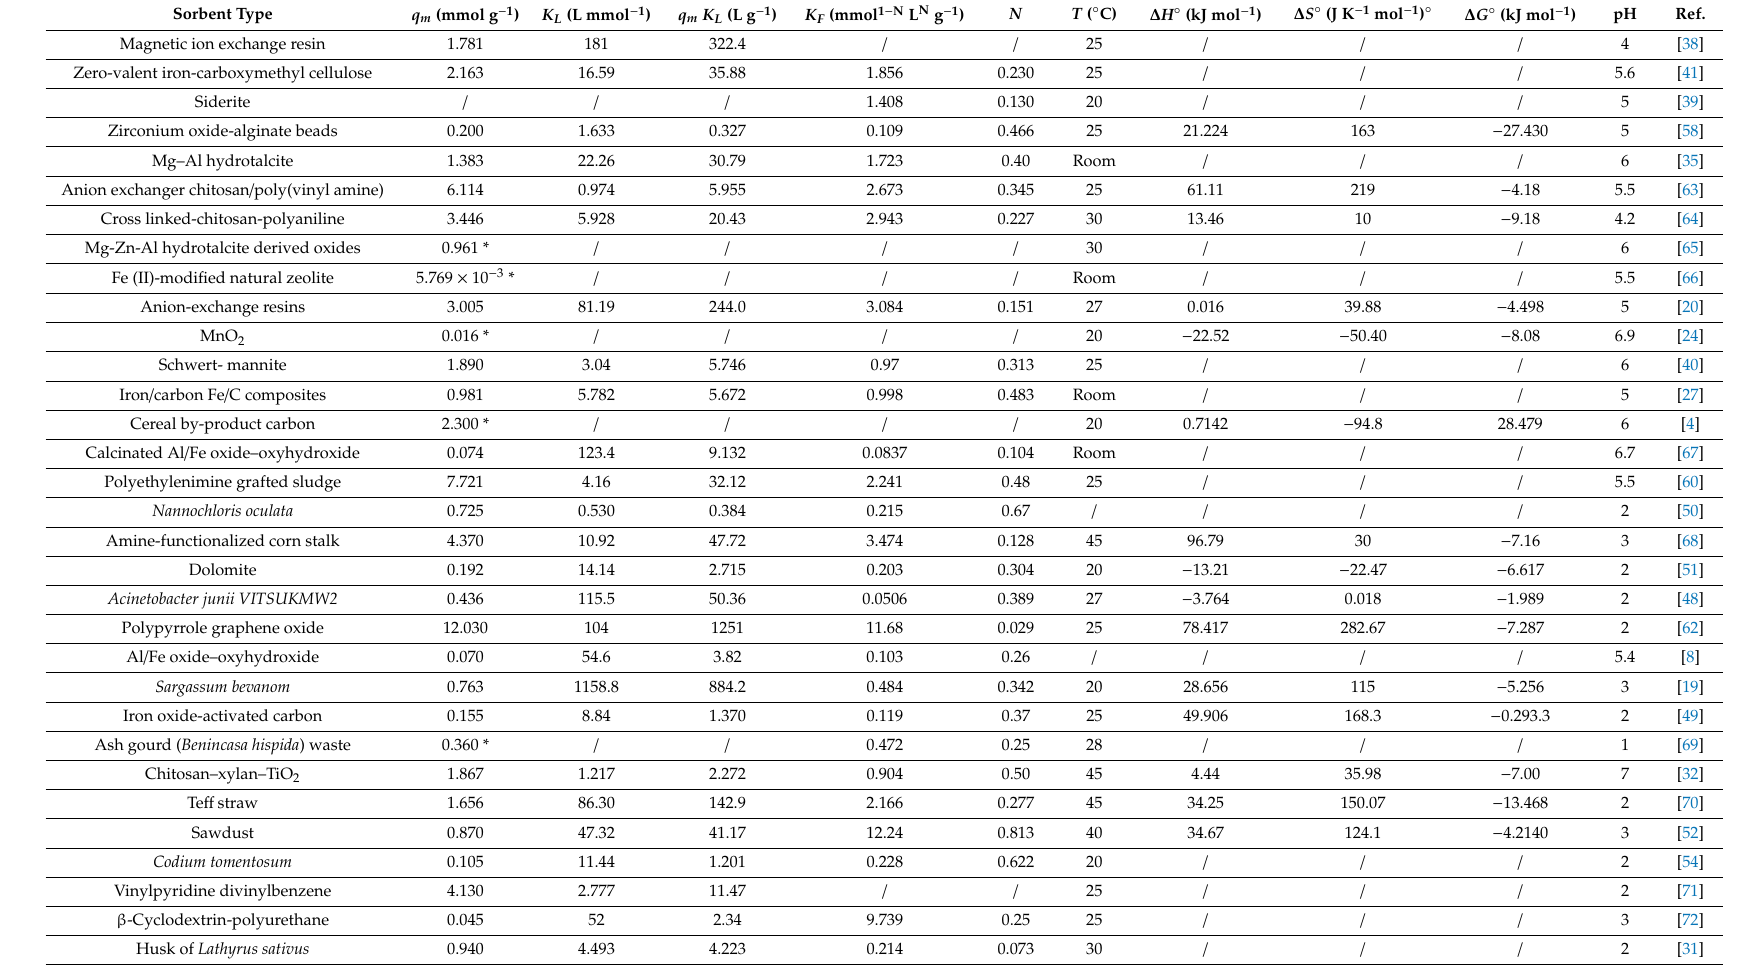
Table 1. Thermodynamic data for Cr(VI)